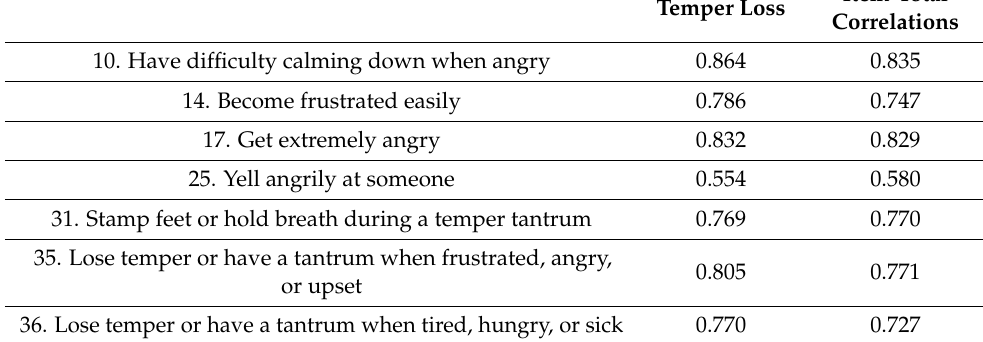
Table 3. Rotated factor loadings of the Exploratory Factor Analysis (EFA) for the 22 items of the Subscale ‘temper of loss’ of the MAP-DB questionnaire (N = 400) item-total correlation and Cronbach’s alpha